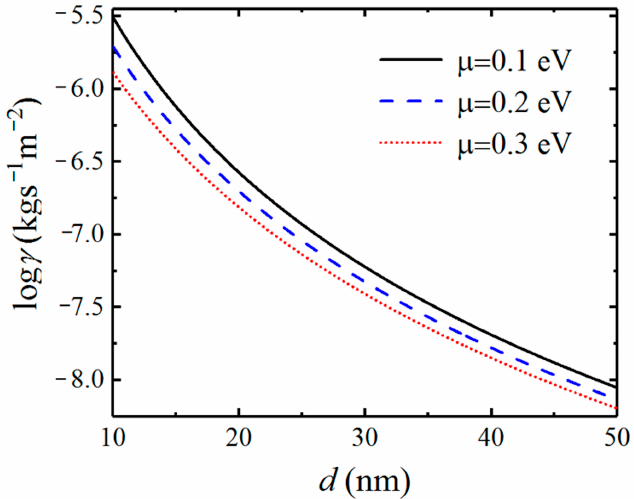
Figure 6. Dependence of the Casimir friction coefficient between graphene-covered Bi 2 Se 3 on the separation distance for different chemical potentials of graphene.